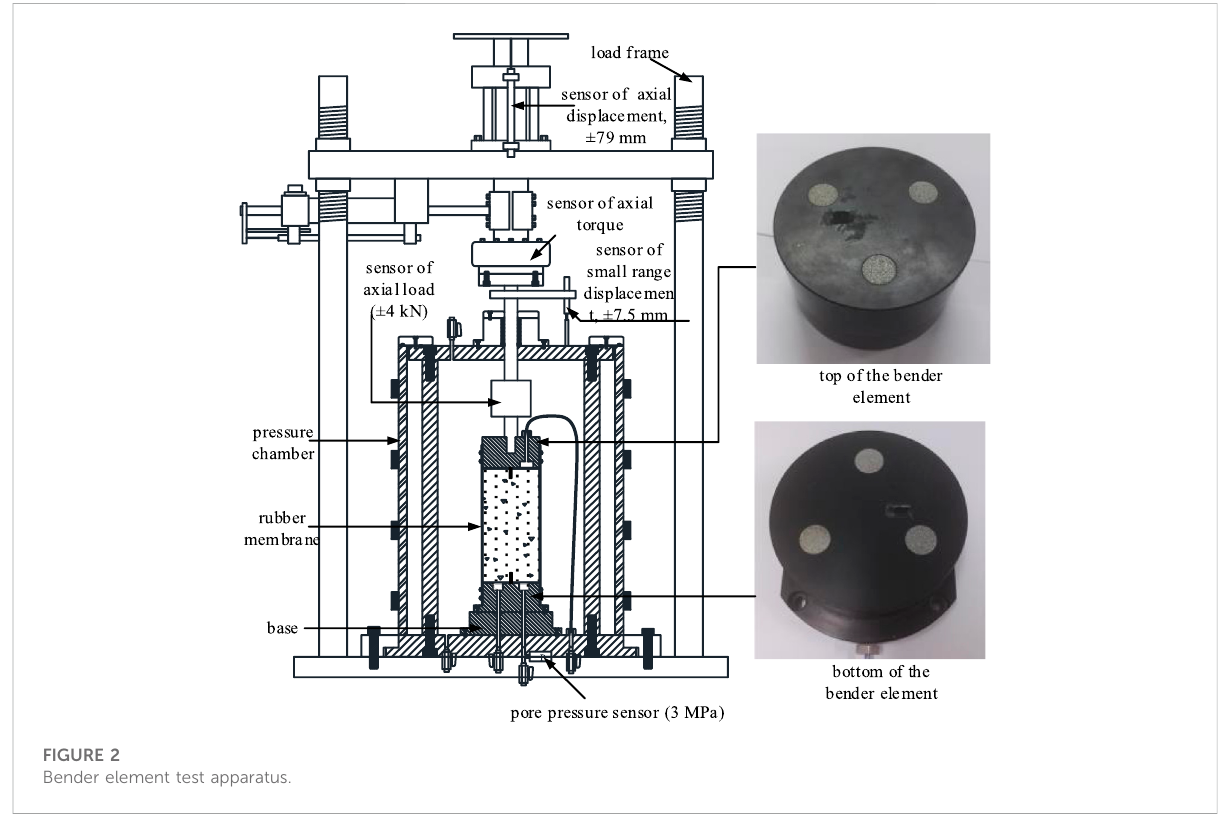
FIGURE 2 Bender element test apparatus.